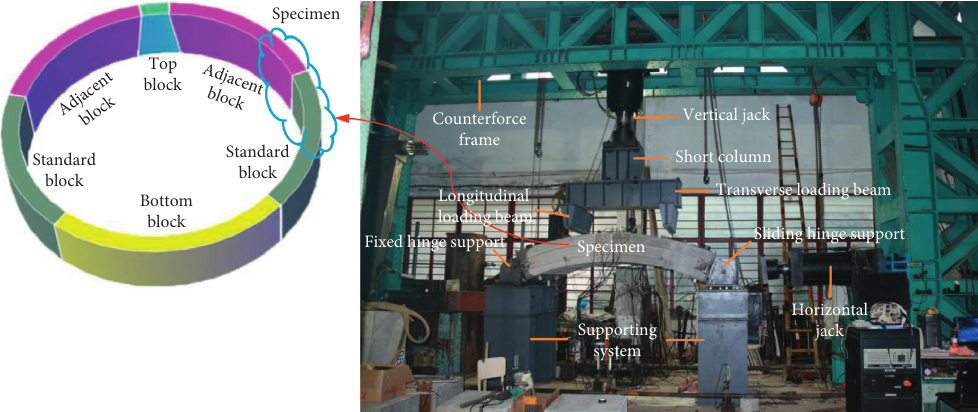
Figure 1: Experimental setup and specimen. The specimen had a central angle of approximately 46 ° . Two high-strength bolts were used to connect the two segments.